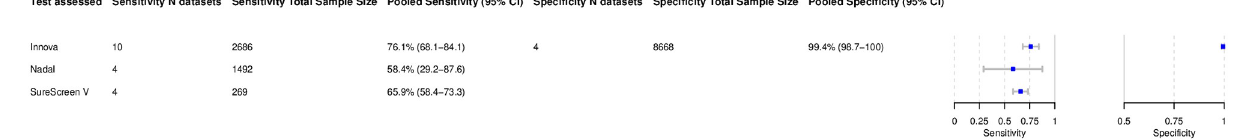
Fig 5. Univariate analysis of 3 antigen rapid diagnostic tests. Pooled sensitivity and specificity were calculated based on reported sensitivity, specificity, and confidence intervals. SureScreen V, SureScreen Diagnostics COVID-19 Rapid Antigen Visual Read.